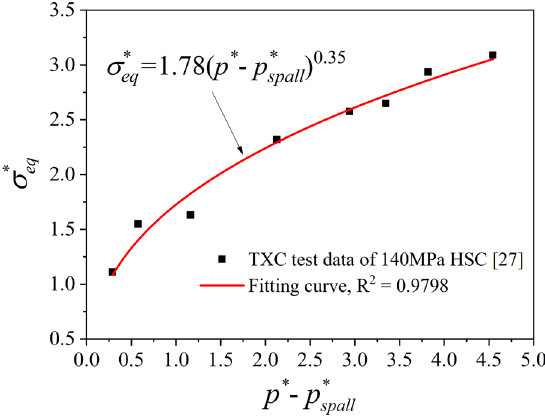
Figure 11. Determination of the parameters A fail and N fail . Table 3. Parameters of material models for the UHPC matrix, loading plate, and steel fibers (units: cm-g-µs).